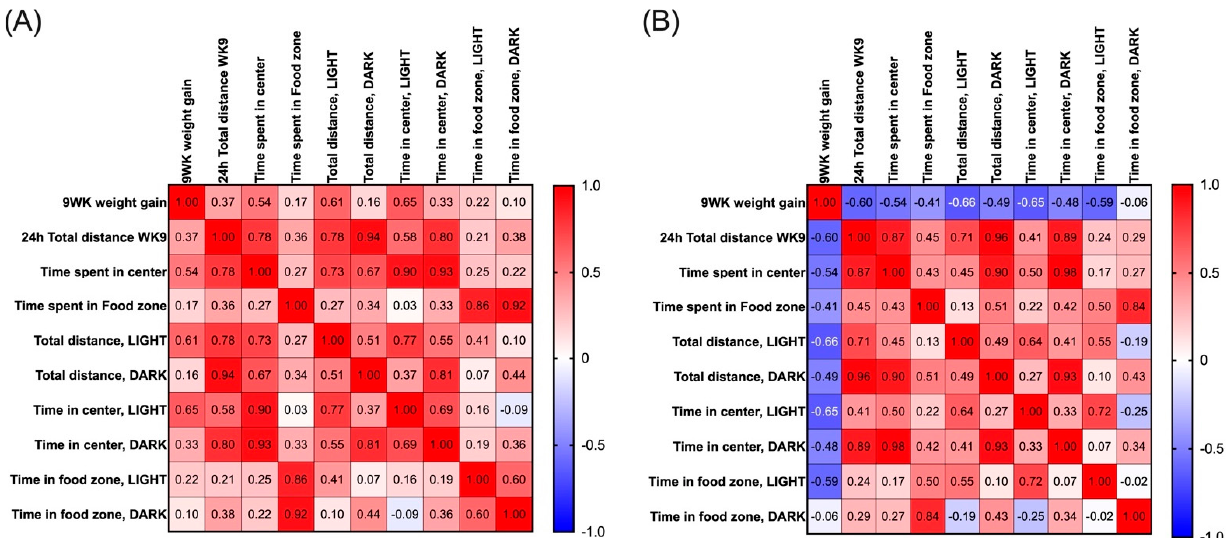
Figure 3. Heat-map of Pearson correlation coefficients between 9-week weight gain and locomotor parameters in ( A ) Bl6 and ( B ) 129Sv HFD-fed mice.